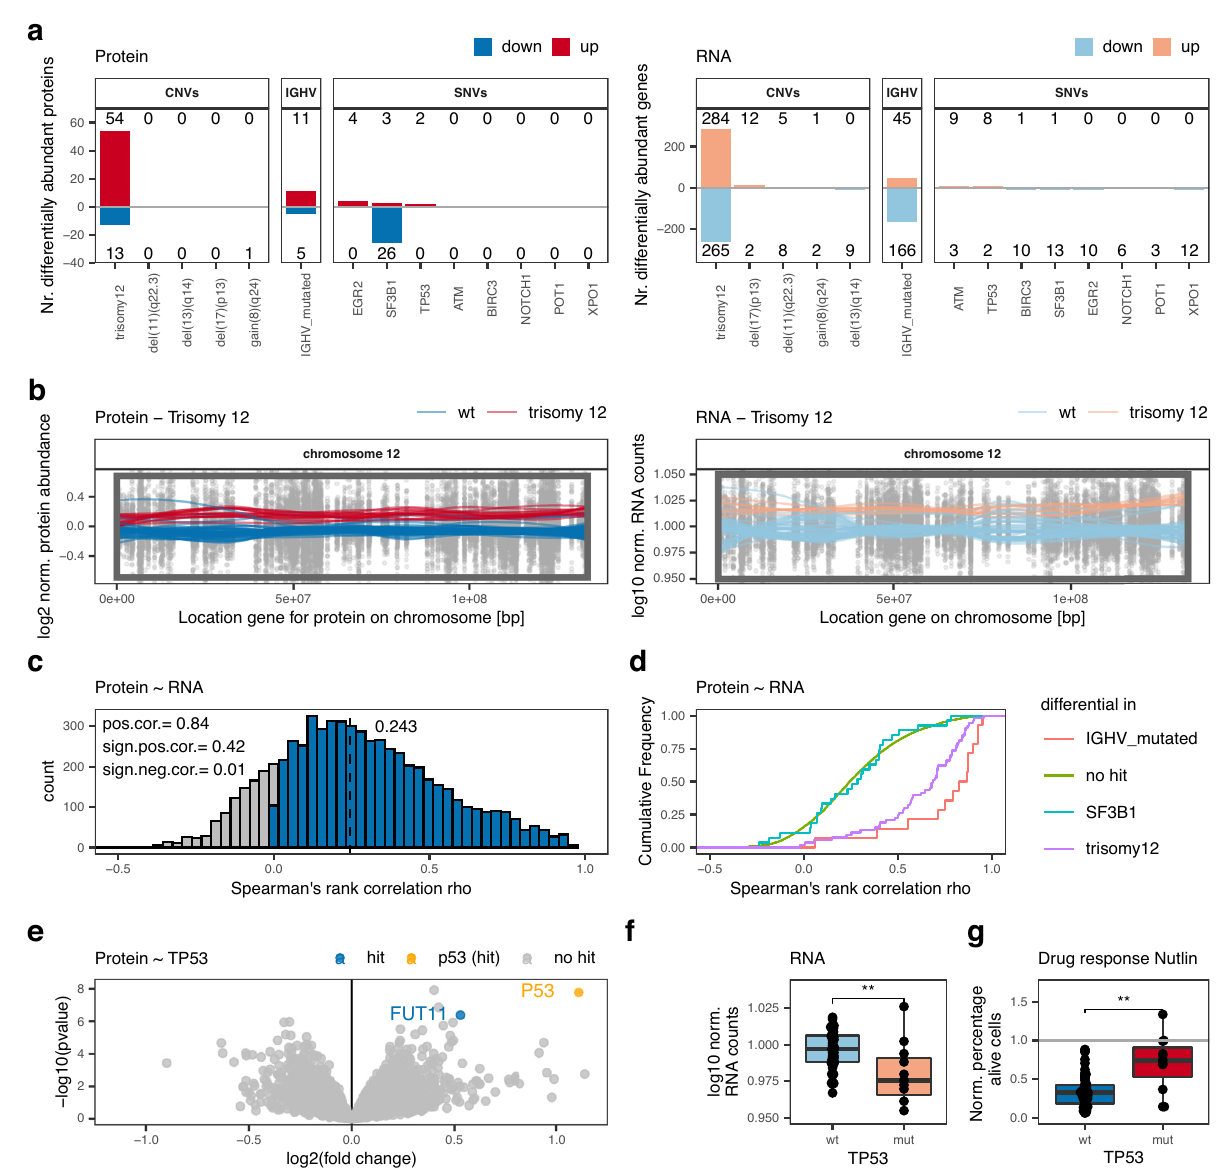
Fig. 2 | Interplay between genetic alterations, proteomics, and tran- scriptomics. a Number of signi fi cantly differentially abundant proteins (left; FDR<0.1%; |log2FC|>0.5) and differentially expressed genes (right; FDR<0.1%; | log2FC|>1.5) in relation to recurrent genetic alterations. b Levels of both proteins and transcripts from chromosome 12 and the impact of trisomy 12. Normalized protein abundance (left panel) and gene expression levels (right panel) for chro- mosome 12 areshown. Points represent individualvaluesfor protein/gene – patient pairs.Linesarelocallyweightedscatterplotsmoothedvaluesforindividualpatients with(red)orwithout(blue)trisomy12.Theboxistheregionaffectedbytrisomy12. c Distribution of Spearman ’ s rank correlations for protein-mRNA pairs. d Cumulative density distribution of protein-mRNA Spearman ’ s rank correlations fortheproteinssigni fi cantlydifferentiallyabundantinIGHVmutated(red),trisomy